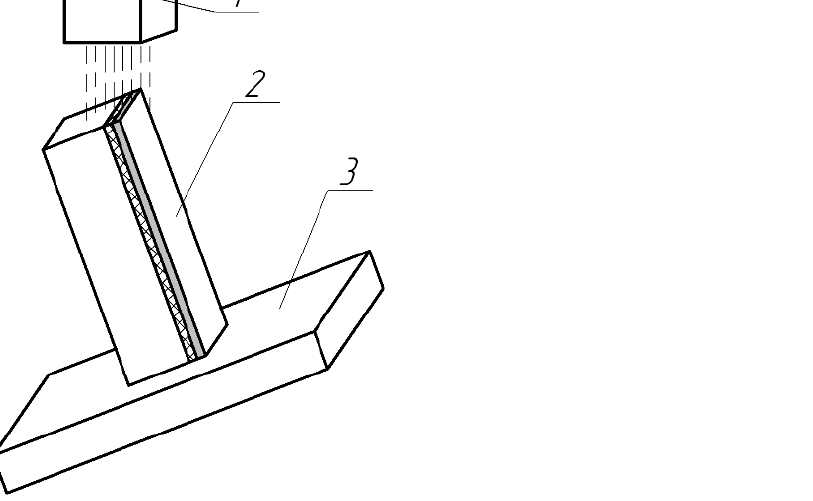
Figure 3. Installation of the sample during scanning: 1—detector; 2—sample; 3—the table.